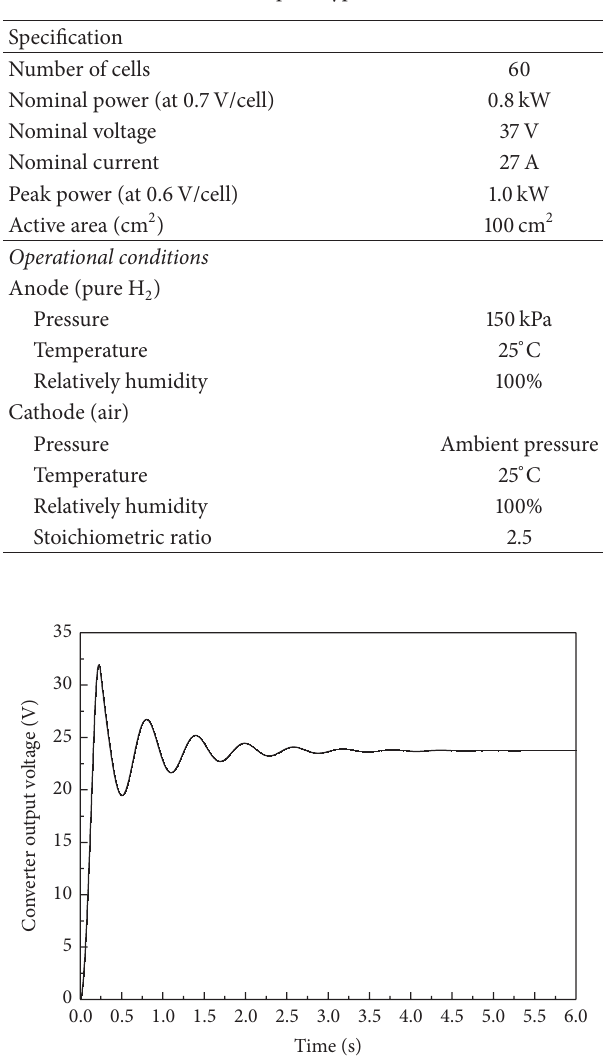
Table 1: Nominal data of prototype 1.0kW PEMFC stack.